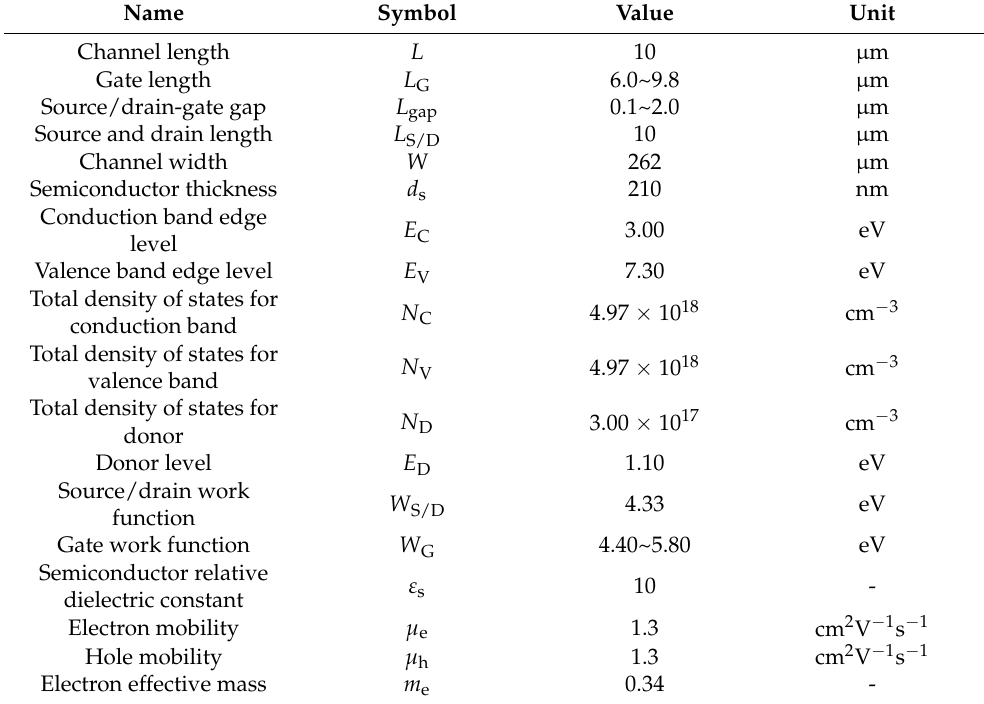
Table 1. Parameters used for TCAD